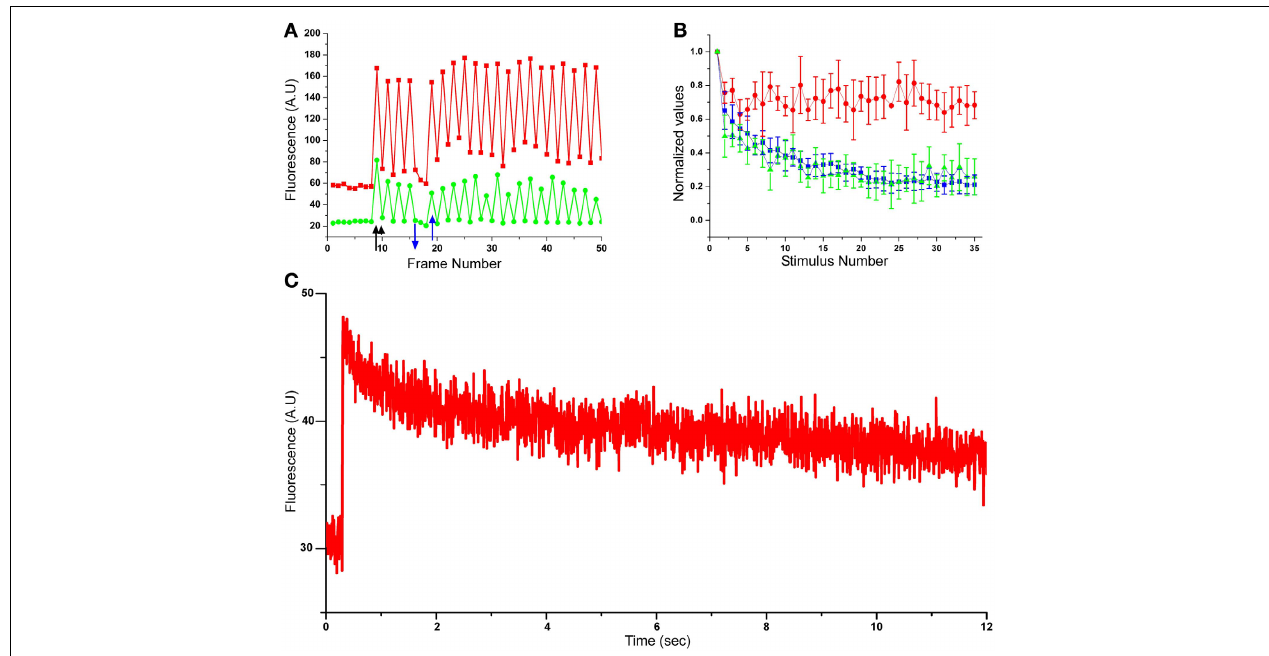
FIGURE 2 | Concomitant monitoring of EPSPs, pre- and postsynaptic calcium concentration transients during homosynaptic habituation. (A) Raw data of pre- and postsynaptic calcium imaging from a single release site. In red, presynaptic rhod-2, in green the corresponding EPSCaT imaged by fluo-4 (green). A few images were grabbed from the presynaptic bouton and the corresponding postsynaptic site prior to presynaptic stimulation. The fluorescent signals generated by the first stimulus (indicated by an arrow) generated increased pre- and postsynaptic fluorescent signals. The next value on the graph (indicated by an arrowhead) was grabbed 10s later when no stimulus had been delivered. Note that because of the long decay time of the presynaptic calcium concentration (C) , the baseline of the calcium concentration gradually increased in response to the consecutive individual stimuli but reached saturation, i.e., did not continue to increase. When the presynaptic stimuli were stopped (blue arrow pointing down) the rhod-2 signal recovered to the control level (this and the control stretch prior to stimulation demonstrate that no bleaching of the fluorescent signals